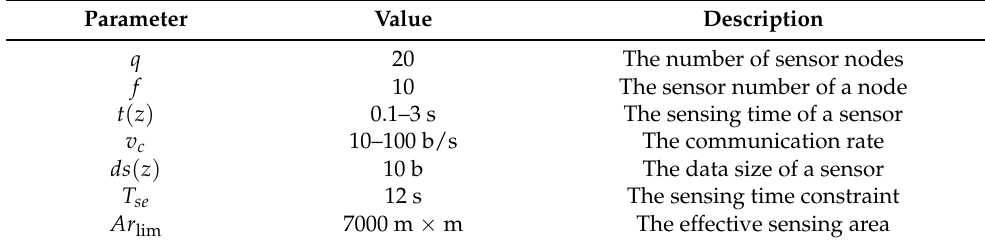
Table 1. Experiment parameters.